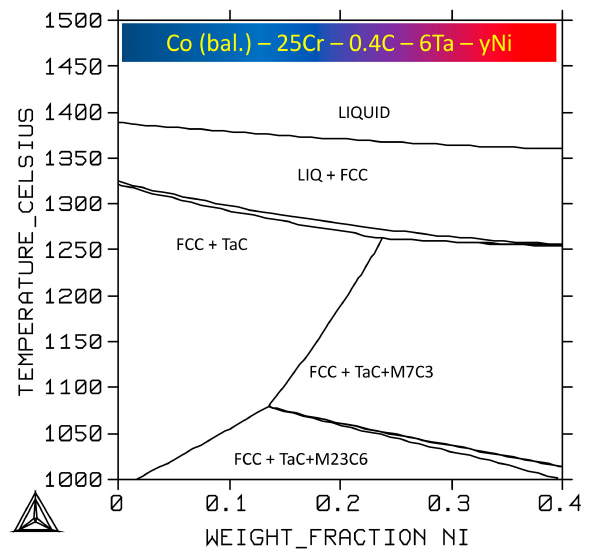
Figure 11. Isopleth section at 25 wt % Cr, 6 wt % Ta and 0.4 wt % C of the quinary Co-Ni-Cr-C-Ta diagram (computed with Thermo–Calc N and a home-made thermodynamic